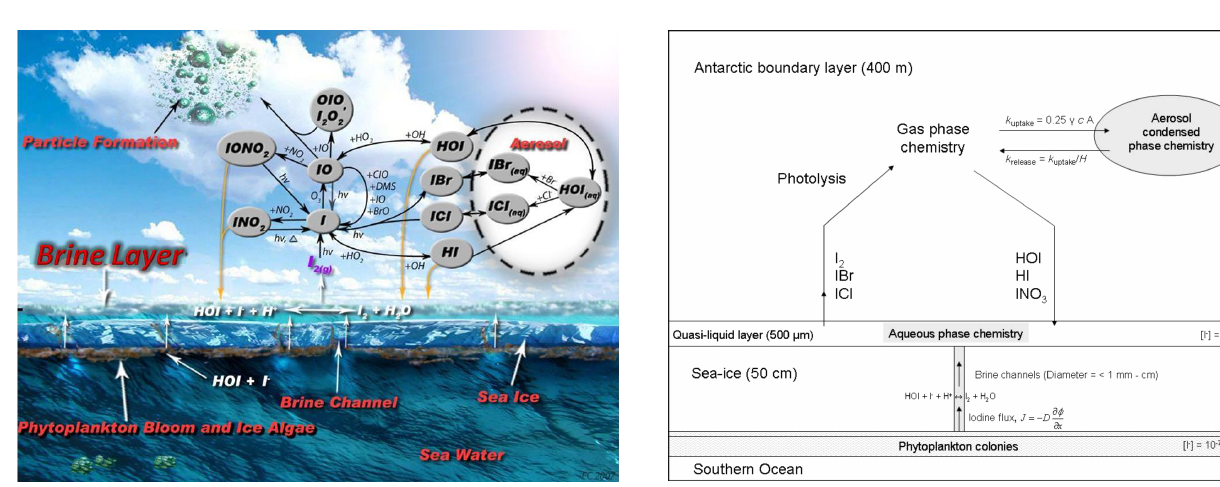
Figure 1. A simplified scheme of iodine cycling in and over Antarc- tic sea ice. The biological release of iodine into brine channels oc- curs in and on the underside of Antarctic sea ice. Subsequently, dif- fusion of iodine through brine channels allows for the accumulation of these species in the BL, releasing I 2 ( g ) to the atmosphere via gas-phase equilibration. Thereafter transformations of compounds occur in the gas phase, as well as in deliquesced sea-salt aerosol.